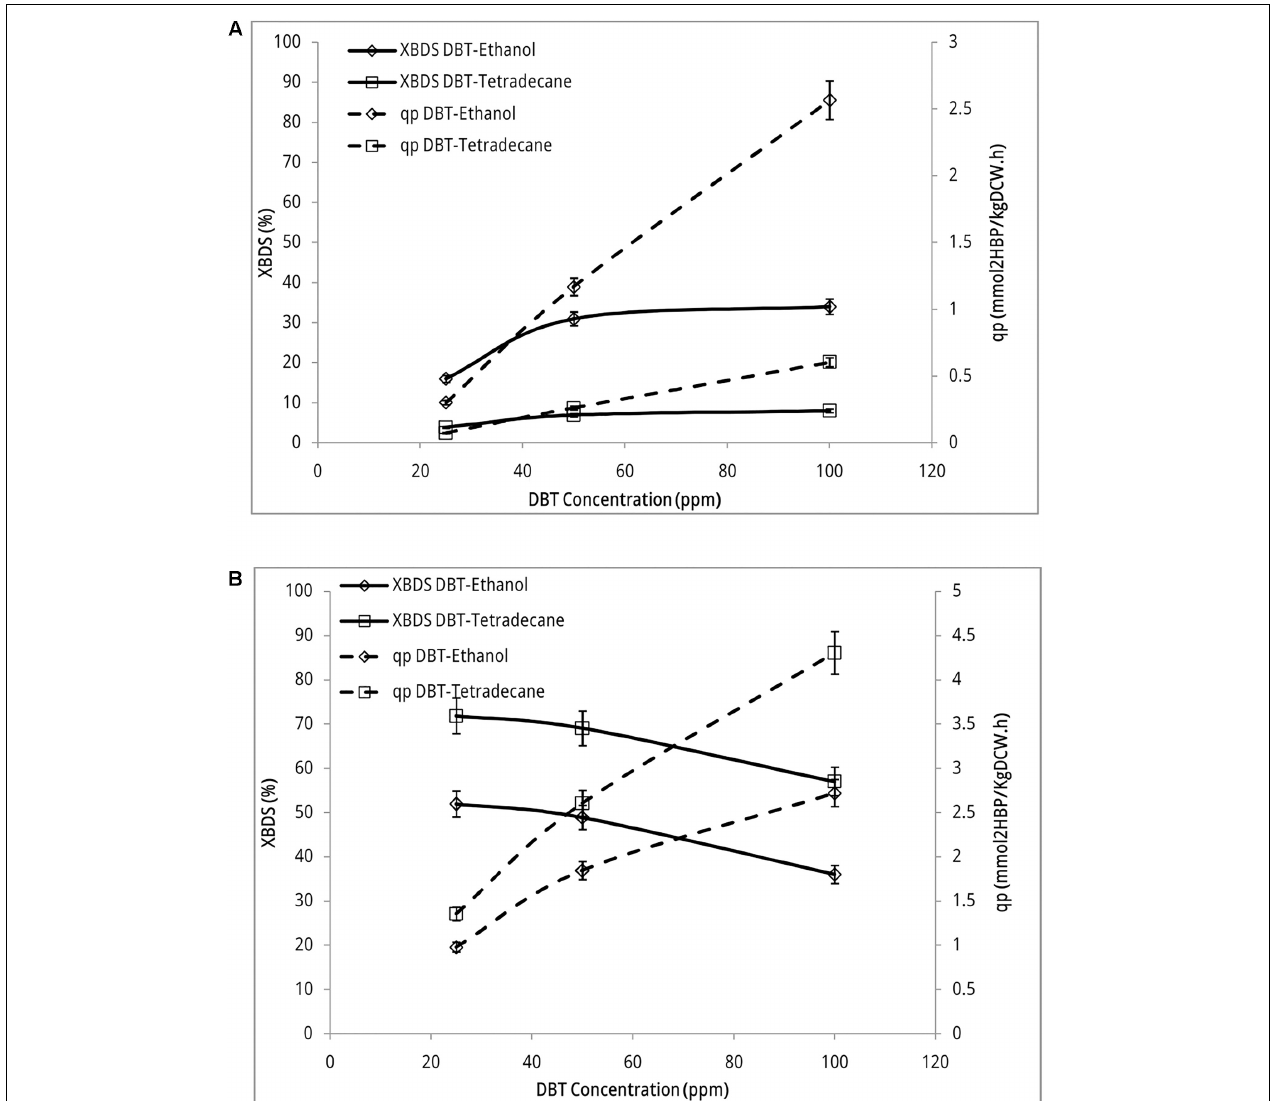
FIGURE 3 | Desulfurization activity of recombinant E. coli BL21 strain (A) and Rhodococcus sp. FUM94 (B) at different DBT concentrations. “DBT-Ethanol” represents DBT dissolved in ethanol (aqueous phase) and “DBT-Tetradecane” represents DBT dissolved in n -tetradecane (organic phase). Aqueous to organic phase ratio: 3:1, reaction time: 12 h, biocatalyst concentration: 2 gl − 1 . 2-HBP specific production rate (q p ) defined as the quantity of 2-HBP produced per hour per kilogram of dry cell weight, [mmol 2-HBP (kg DCW) − 1 h − 1 ] and BDS yield (X BDS ) defined as the ratio of the 2-HBP produced to the initial substrate